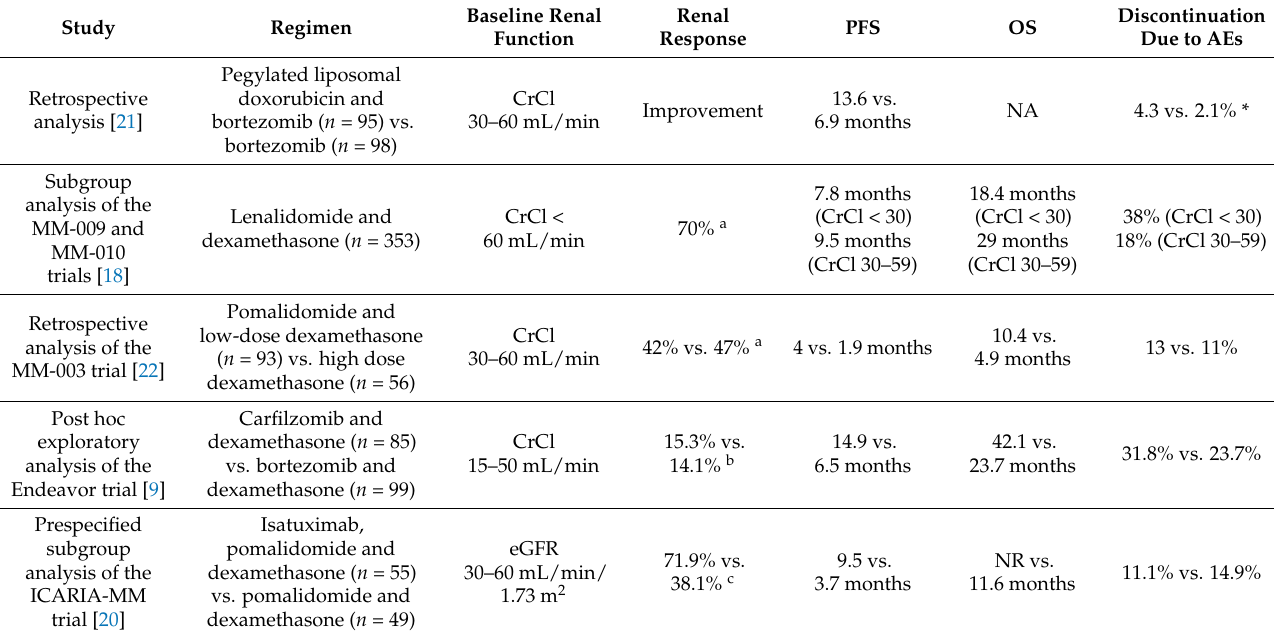
Table 1. Overview of renal response in phase 3 clinical trials in RRMM with